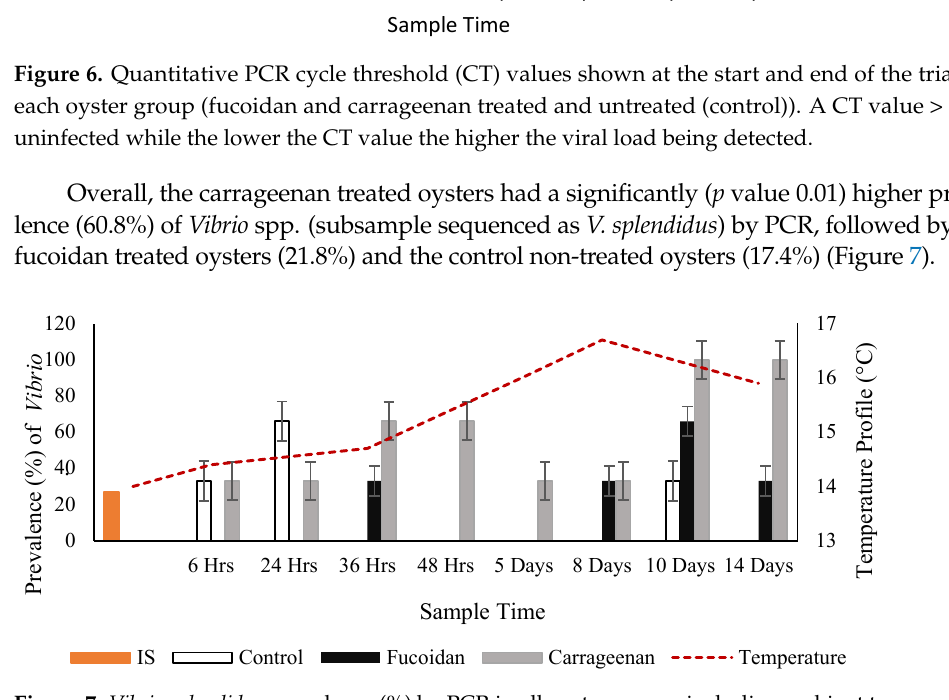
Figure 7. Vibrio splendidus prevalence (%) by PCR in all oyster groups including ambient temperature .